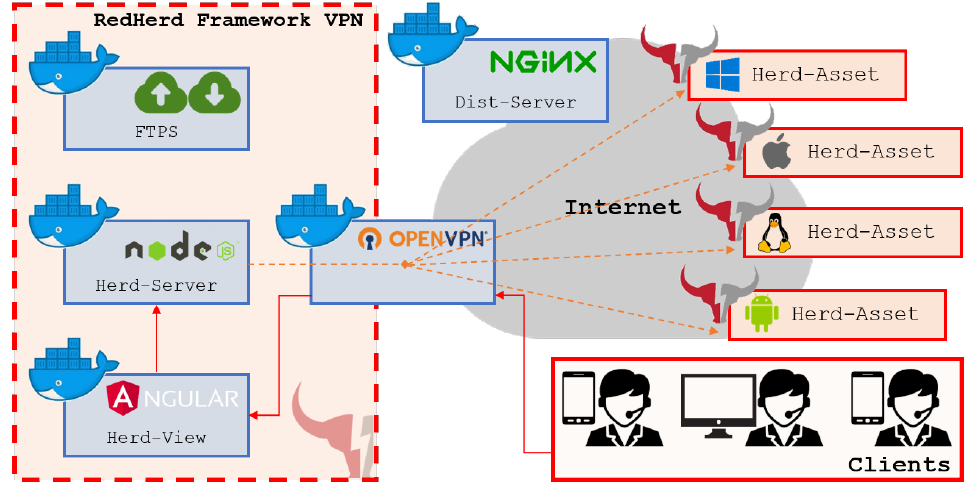
Figure 1. RedHerd